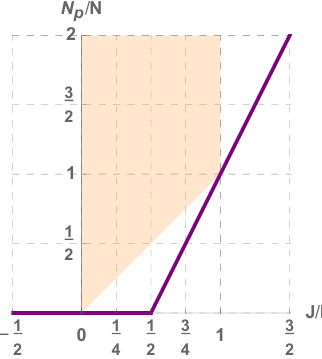
Figure 3 . The region in which states counted by z bos bound below which no states